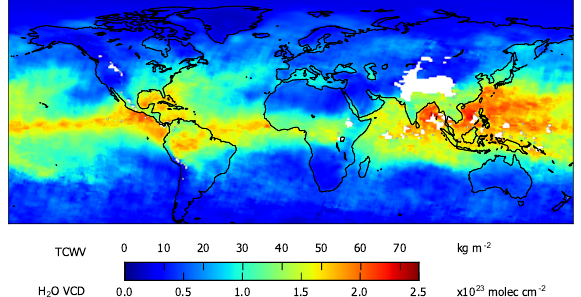
Figure 1. Sample monthly mean TCWV from GOME measure- ments in June